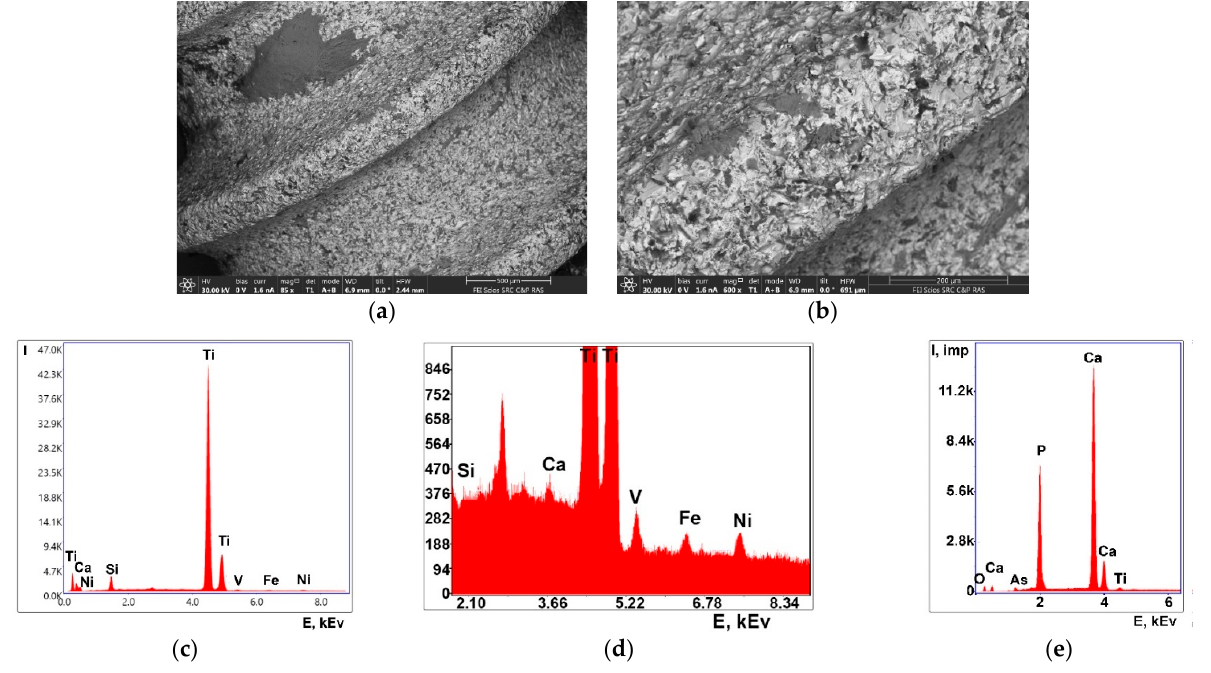
Figure 3. SEM images of the implant surface: ( a ) General view; ( b ) enlarged fragment; ( c ) general ED spectrum from the dark area; ( d ) enlarged section of ED spectrum from the dark area; ( e ) general ED spectrum from the light area. Table 1. Quantitative composition of one of the dark areas.